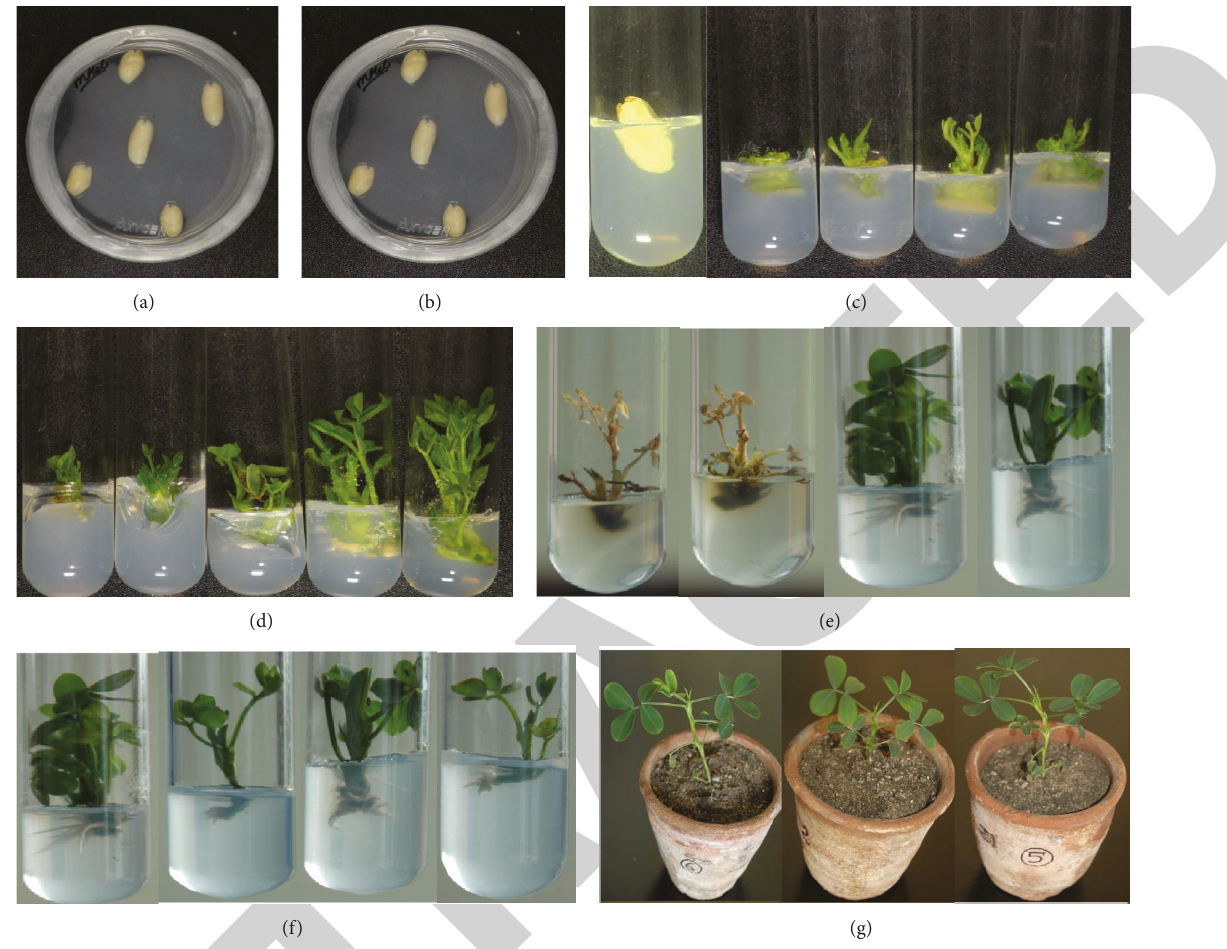
Figure 2: Genetic transformation and regeneration of peanut from deembryonated cotyledons. (a)-(b) Deembryonated cotyledons cocultured with Agrobacterium strain LBA4404; (c) shoot buds initiating from cocultured deembryonated cotyledons; (d) sequential regeneration process of shoots from deembryonated cotyledon explant in various concentration media; (e) transformed (green) and nontransformed shoots (yellow) in Kanamycin selection media; (f) transformed healthy shoots in Kanamycin selection media containing NAA; and (g) transformed groundnut plant with well-developed shoots transferred in pots for hardening. Table 1: Genetic transformation and regeneration of peanut explants from the cultivar GG 20. Final recovery of Plantlets hardened Number of Total explants Shoots passed Shoots produced Shoots produced putative and survived in cocultivations cocultured antibiotic selection roots transgenics glasshouse 15 1096 865 532 (61) ∗ 431 (81) 193 (45) 10 (5.18)